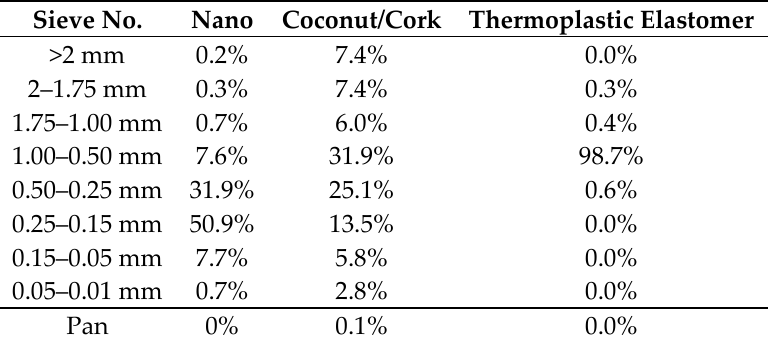
Table 1. Infill particle size analysis